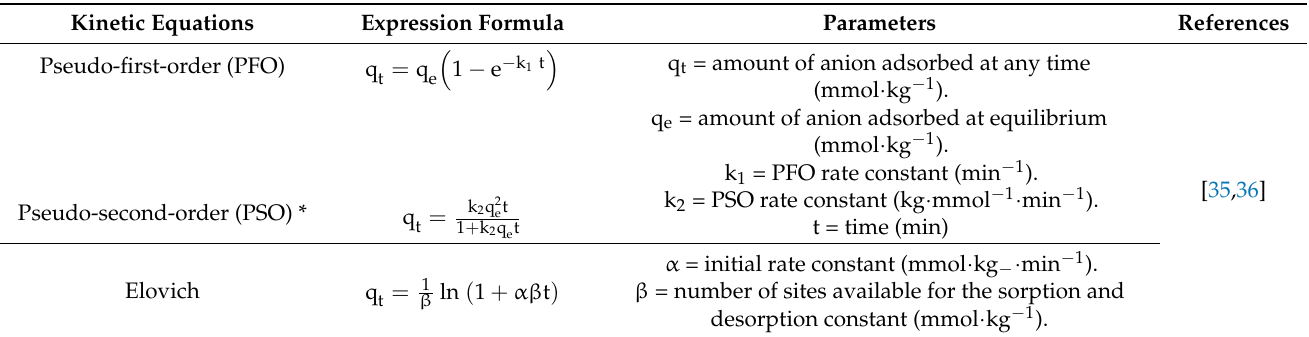
Table 1. The kinetic models used for the description of phosphate adsorption.